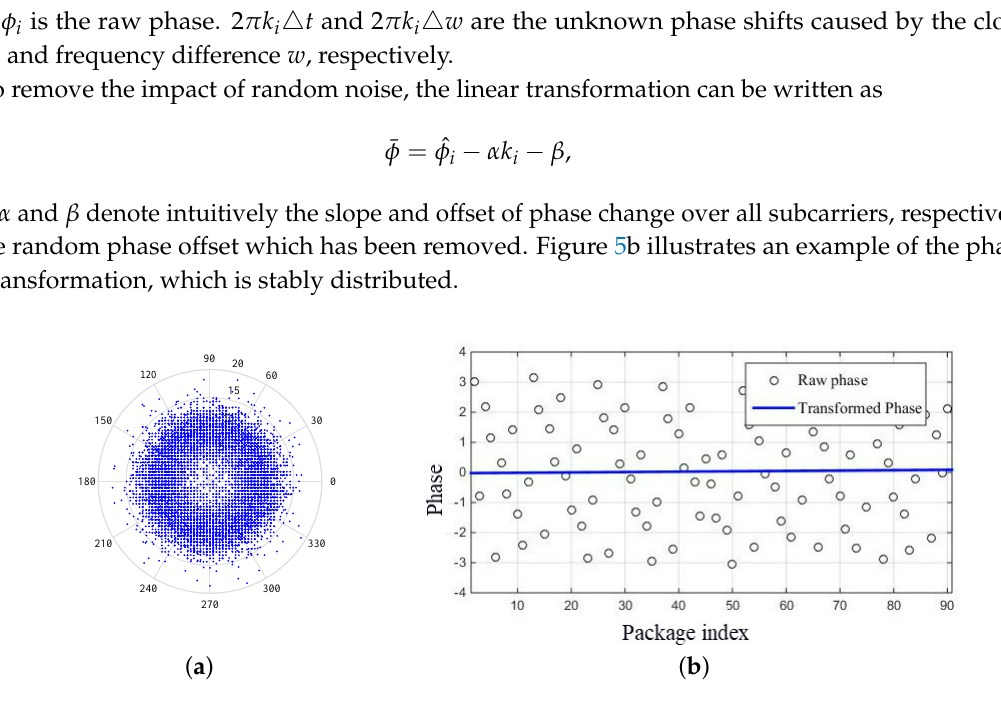
Figure 5. Phase before and after linear transformation. ( a ) random raw phase measurements; ( b ) phase after linear